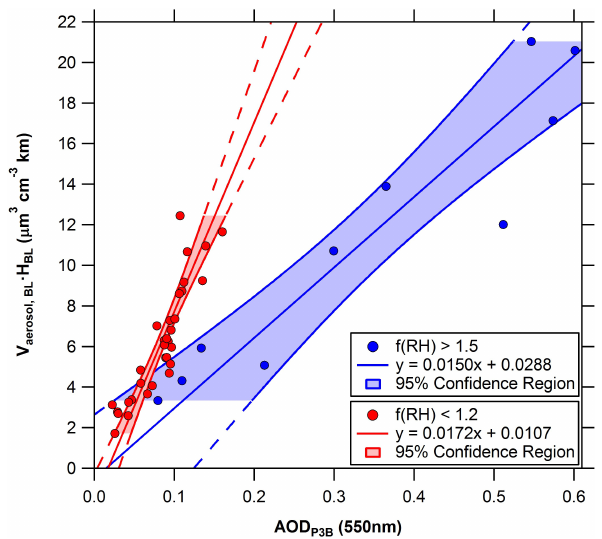
Fig. 10. Aerosol volume concentration averaged in the BL weighted by the BL height, when the aerosols present in the BL are contribut- ing at 60% and more, as a function of the AOD 550 nm from the P-3B measurements. The colors correspond to f (RH) amb , 550 nm values lower than 1.2 (red) and larger than 1.5